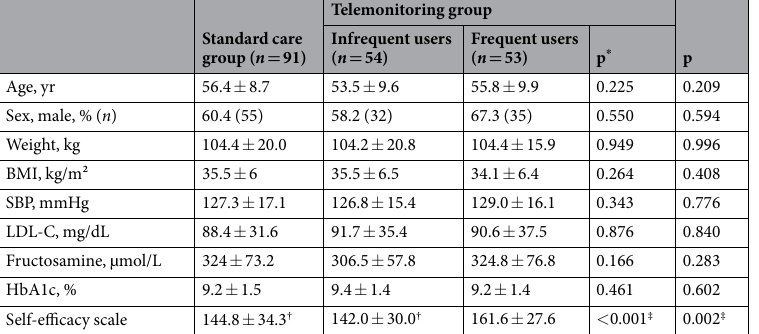
Table 1. Baseline clinical characteristics among the groups. Data are expressed as the mean ± SD. * p value between telemonitoring groups. † No differences between the groups with the same superscript symbol in post- hoc analyses. ‡ p < 0.05.